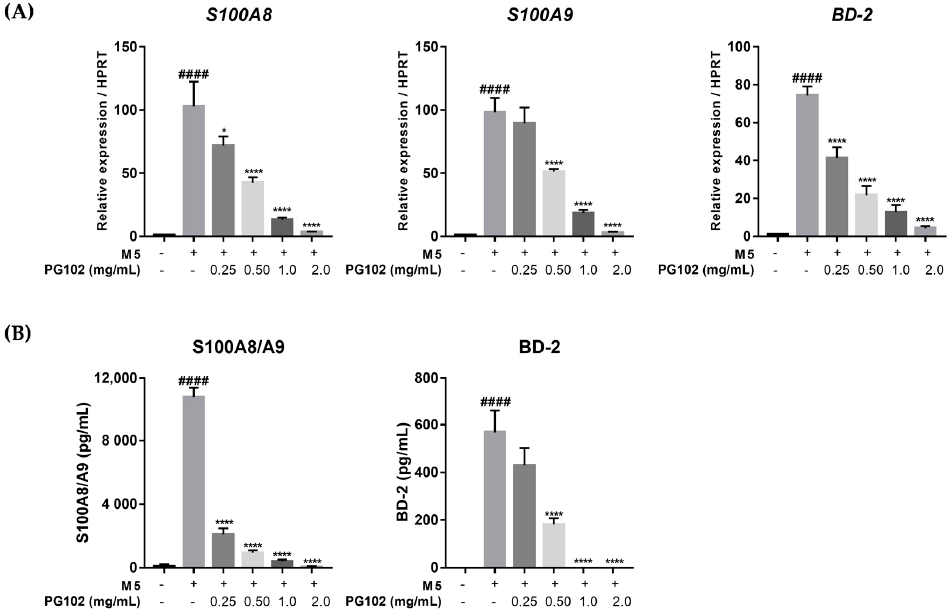
Figure 5. PG102 downregulates expression of antimicrobial peptides on M5-stimulated HaCaT cells in a dose-dependent manner. ( A ) Real-time PCR (qPCR) analysis of mRNA expression levels of antimicrobial peptides after 24 h. ( B ) Protein levels of antimicrobial peptides measured in the cultured supernatant by ELISA after 48 h. BD-2, beta-defensin 2; S100, S100 calcium binding protein. #### p < 0.0001 versus negative control group; * p < 0.05, **** p < 0.0001 versus M5-only treated group.